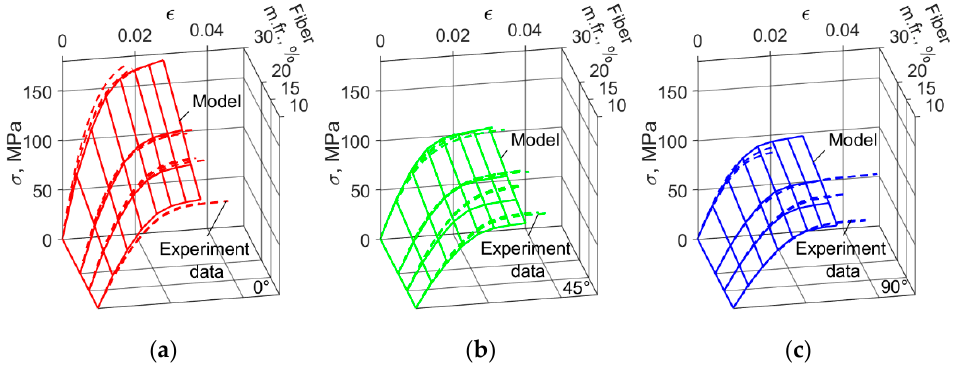
Figure 19. Common mass fraction composite material models for all fibers. Exponent and linear hardening law case. For angles between the flow and load directions: ( a ) 0°; ( b ) 45°; ( c ) 90°.